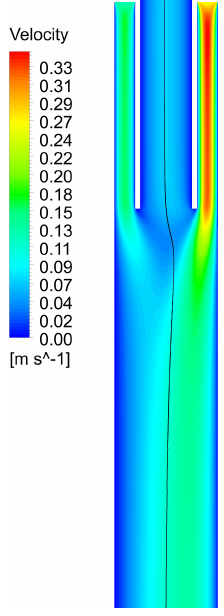
Fig. 3. Flow velocity in the additional sheath air. The additional flow is adjusted to counteract the buoyant displacement of the aerosol layer, depending on 1 T between the cold and the warm wall in ZINC. The black line indicates an example particle